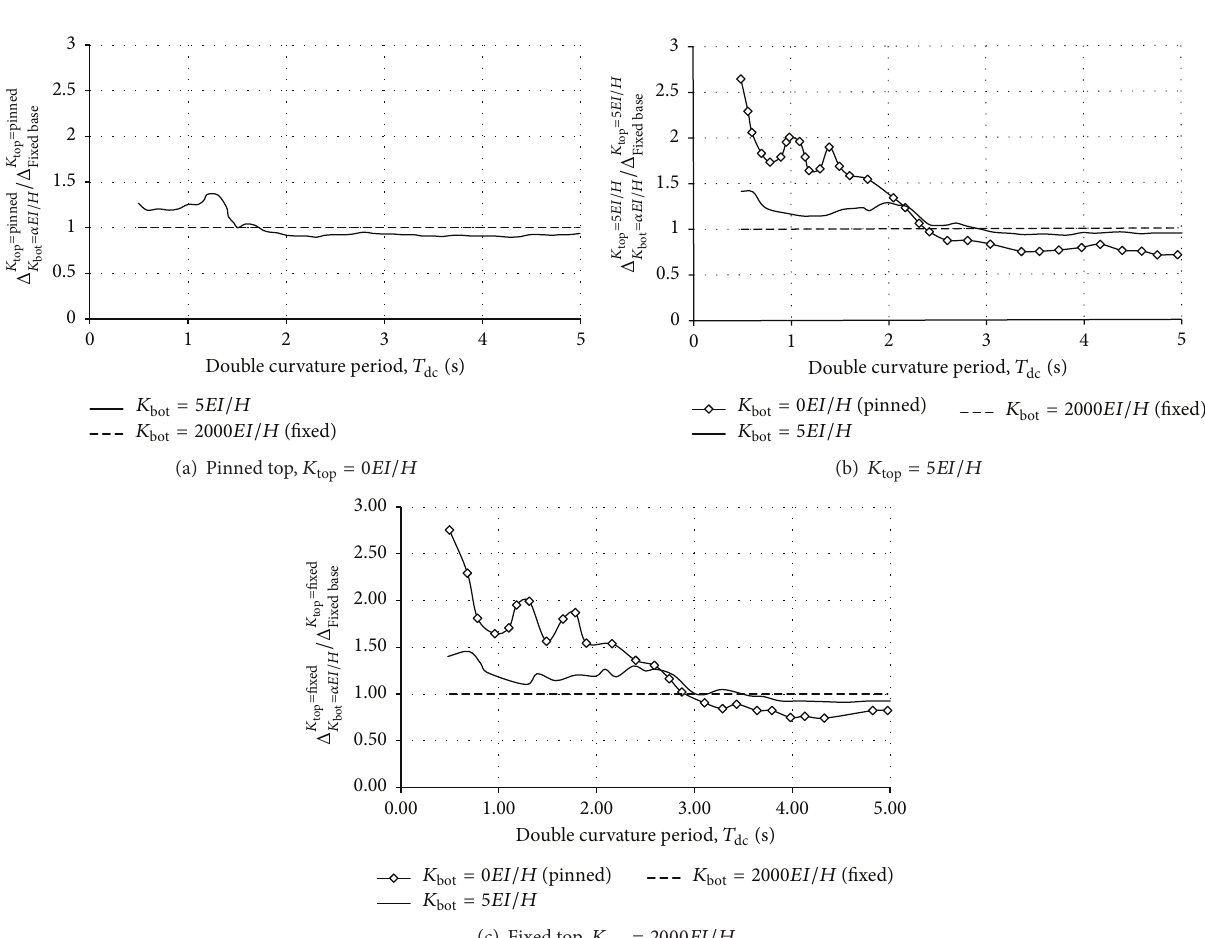
H /( EI ) = 0, 5, and 2000). top